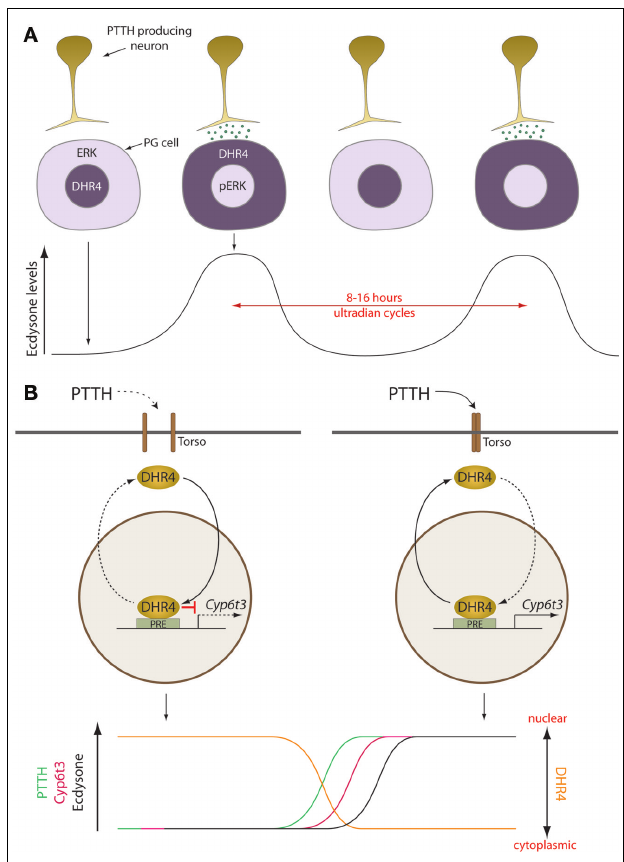
FIGURE 1 | Prothoracicotropic hormone/DHR4 generate cyclic steroid pulses that drive directional developmental transitions. A model illustrating the mechanisms generating 8–16h ultradian steroid oscillations. (A) Each cycle is initiated by the release of PTTH from terminals of brain neurons that activates the Ras pathway in the PG.This results in the phosphorylation and nuclear localization of pERK and translocation of DHR4 to the cytoplasm, which derepresses ecdysone biosynthesis. (B) In the presence of PTTH, the DHR4 repressor is displaced from promoters, including Cyp6t3 increasing its expression. During periods without PTTH signaling, nuclear DHR4 represses gene expression, although DHR4 may act as an activator in some cases. pErk, phospho-ERK; PG, prothoracic gland; PRE, PTTH response element; PTTH, prothoracicotropic hormone. Torso: the transmembrane PTTH receptor in the PG. Dashed arrows indicate inactive